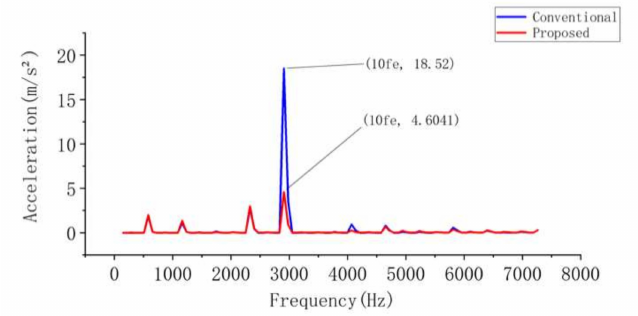
Figure 15. Vibration acceleration of conventional and proposed machine.